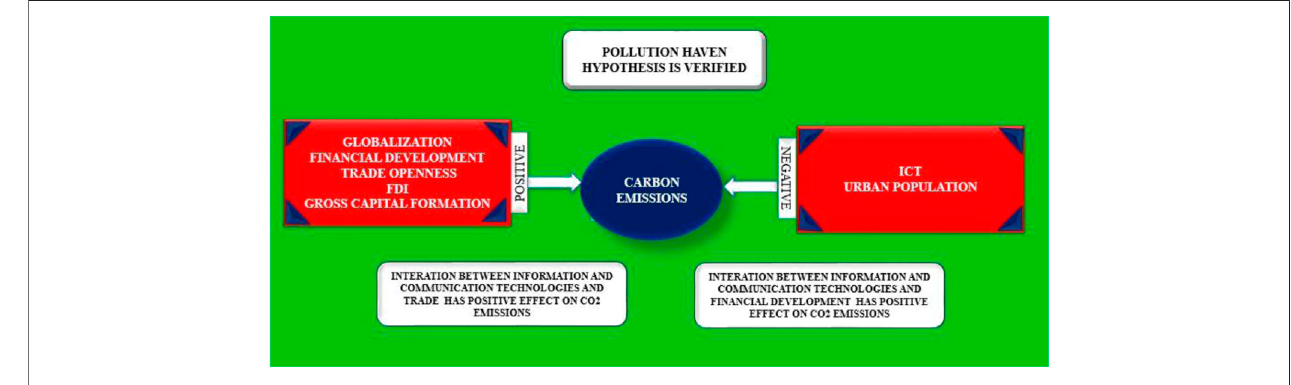
FIGURE 4 | Graphical presentation of empirical results.